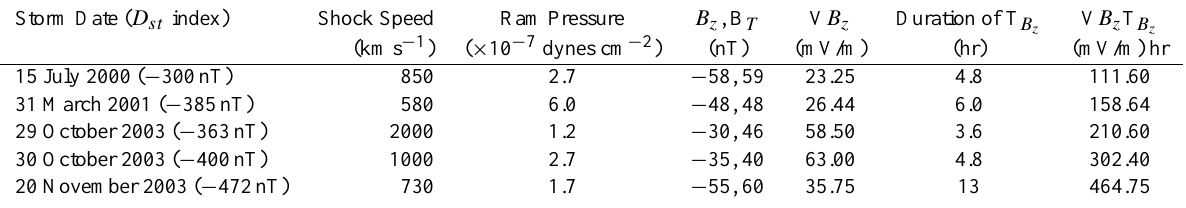
Table 3. Interplanetary consequences of the geo-effective CMEs.